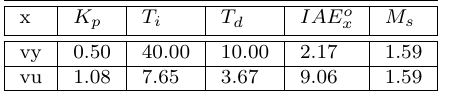
Figure 12: Linear approximation for T i vs. T d , for the POI-PID, i.e. T i = 2 . 0437 T d + 1 . 6216.